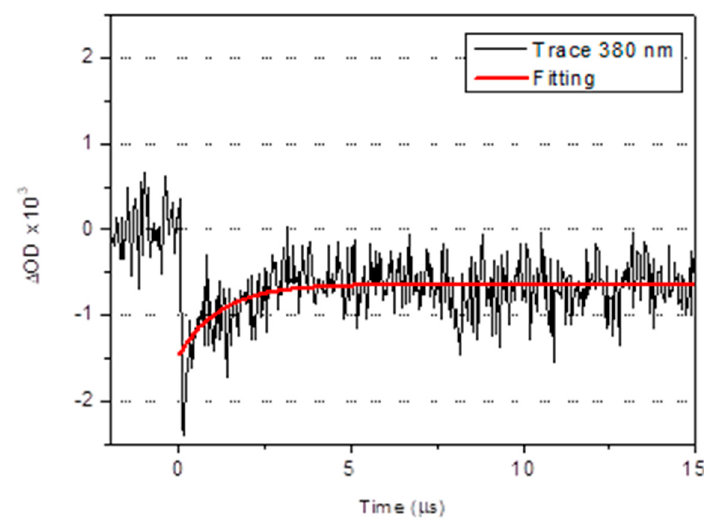
Figure 3. Bleaching and recovery of the transient absorption at 380 nm following excitation with ns pulse of 355 nm for compound 3 in dichloromethane without O 2 .